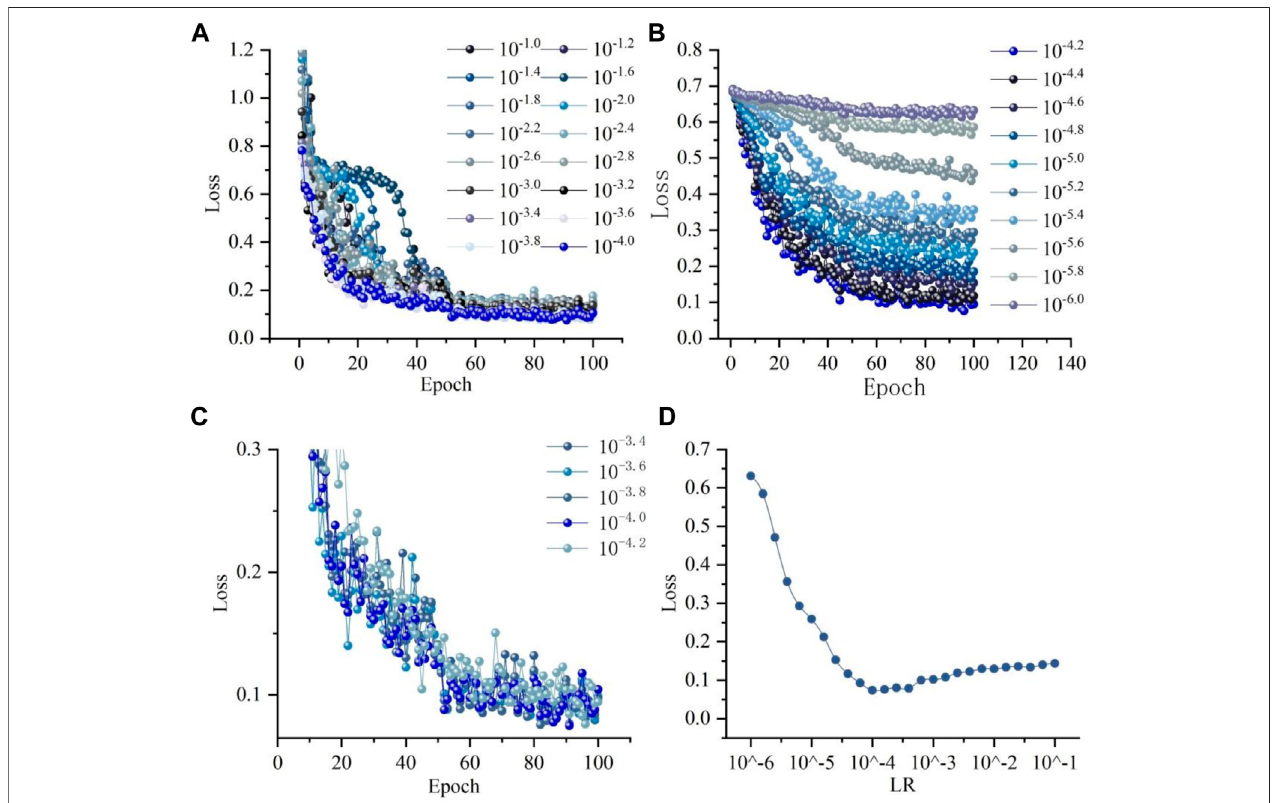
FIGURE 8 | MSLSDA LR optimization results of FFC chromatic aberration experimental data: (A) Experimental results before optimal LR (B) Experimental results after optimal LR (C) Experimental results near optimal LR (D) Optimization process of LR versus loss function on logarithmic scale.